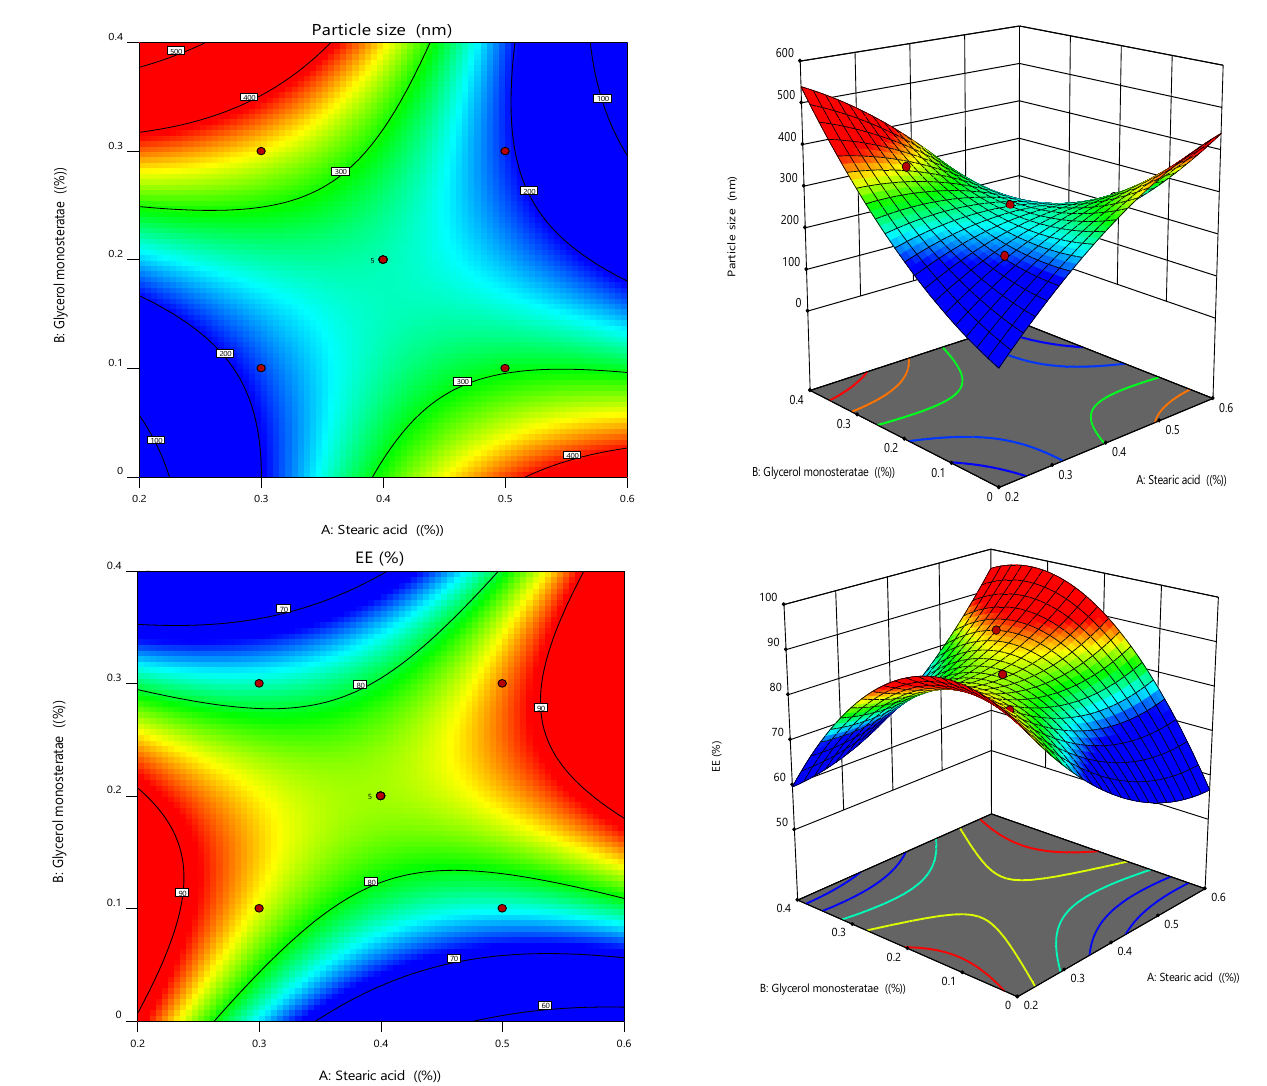
Figure 3. Response surface graphs for EE and in vitro mucoadhesion (3-dimensional and contour).